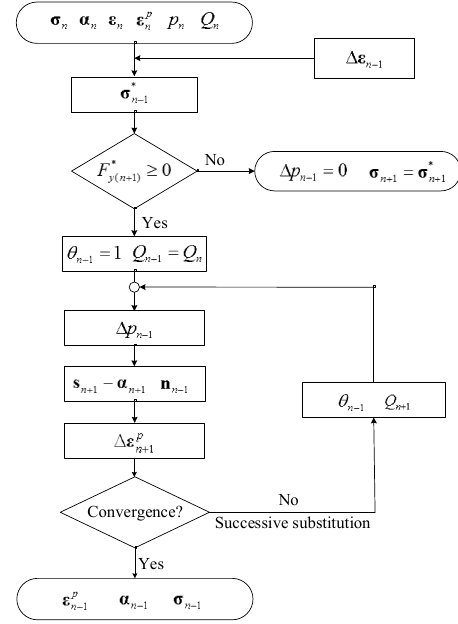
Figure 3. Flow diagram of stress integration algorithm.